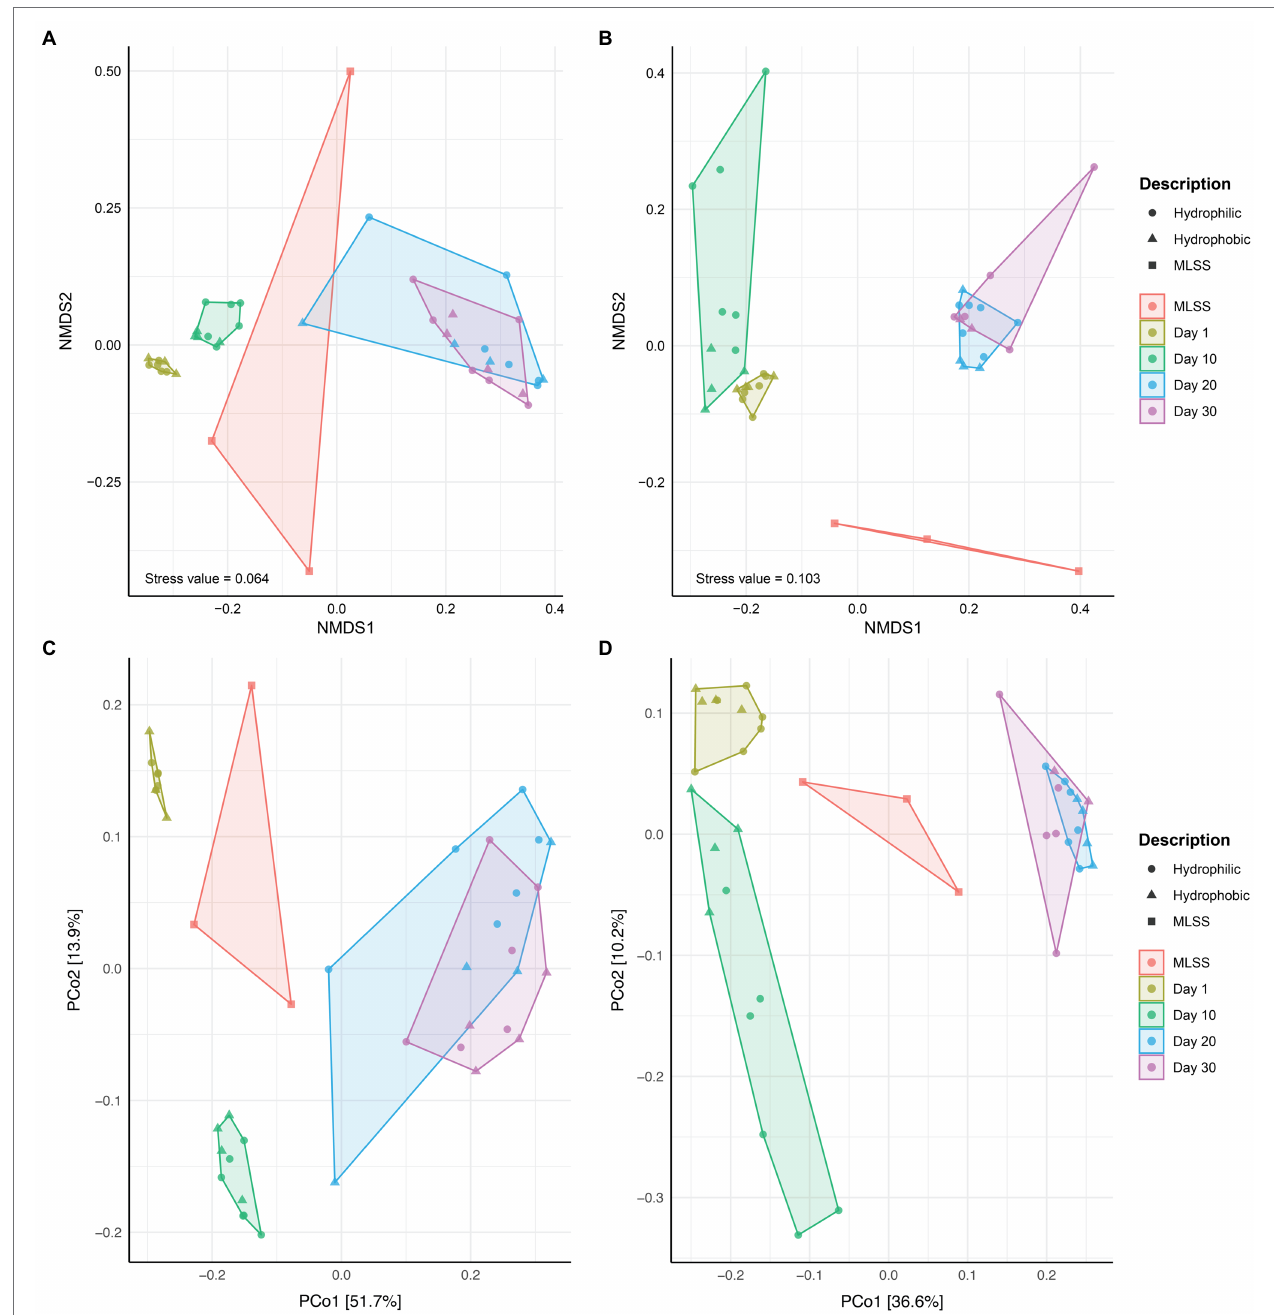
FIGURE 2 | The ordination plots of MLSS and different-aged membrane biofilm samples. Non-metric multidimensional scaling analysis based on Bray-Curtis (A,B) and Principal Coordinates Analysis (PCoA) based on Unweighted UniFrac (C,D) distance metrics. Microbial community diversity according to variances in 16S rRNA gene dataset from DNA (A,C) and cDNA (B,D) samples. These plots were generated based on a rarefied dataset sub-sampled to 4,386 sequences per sample. The dataset used in this analysis includes both flux and no flux